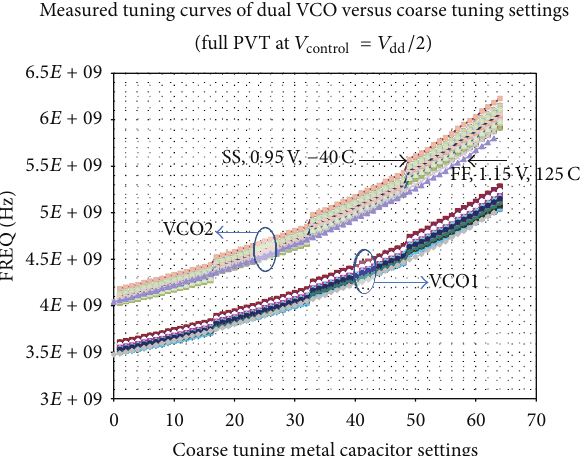
Figure 9: Measured tuning curves of dual LC VCOs across PVT corners.